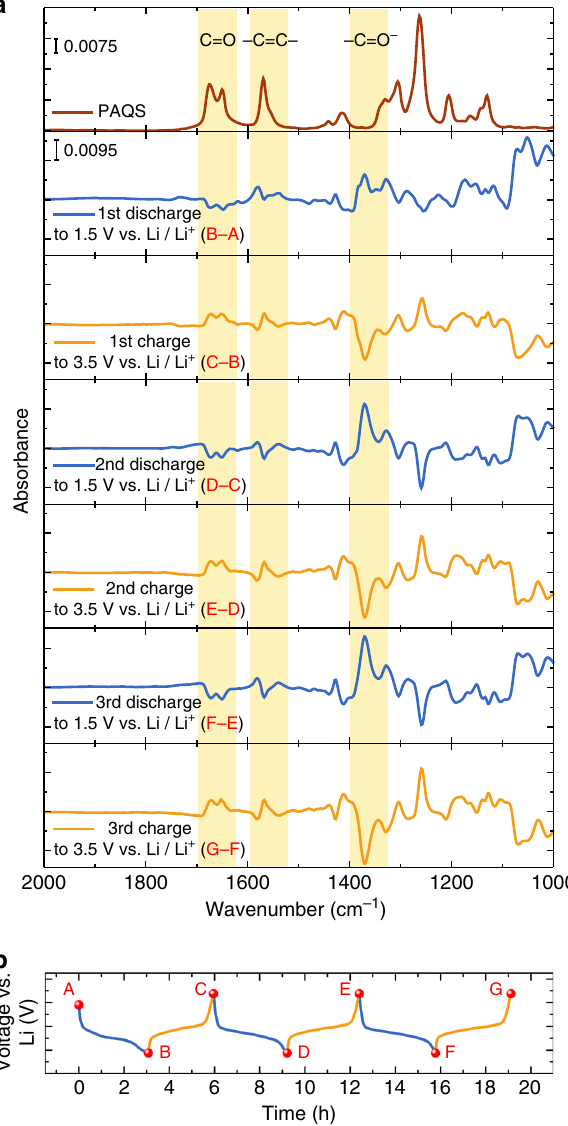
spectra of the PAQS cathode during cycling. The absorbance scale is identical for all difference spectra. b The fi rst three cycles for PAQS cathode vs. time with the marked points from where the subtracted spectra were